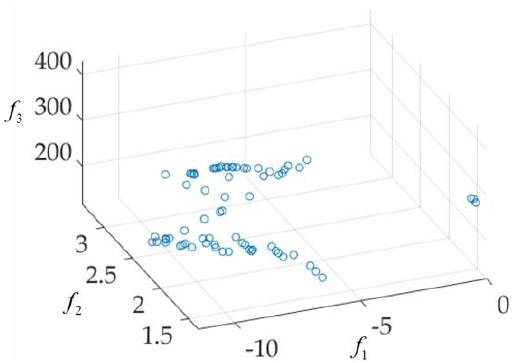
Figure 11. The approximate Pareto front found by GSDP.